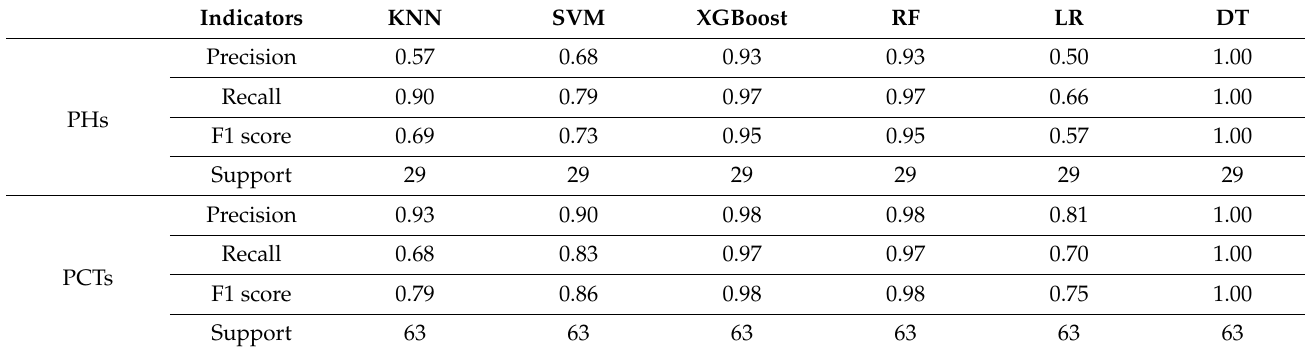
Table 5. Outcomes for four indicators, including precision, recall, F1 score, and support for the test set using the second model.